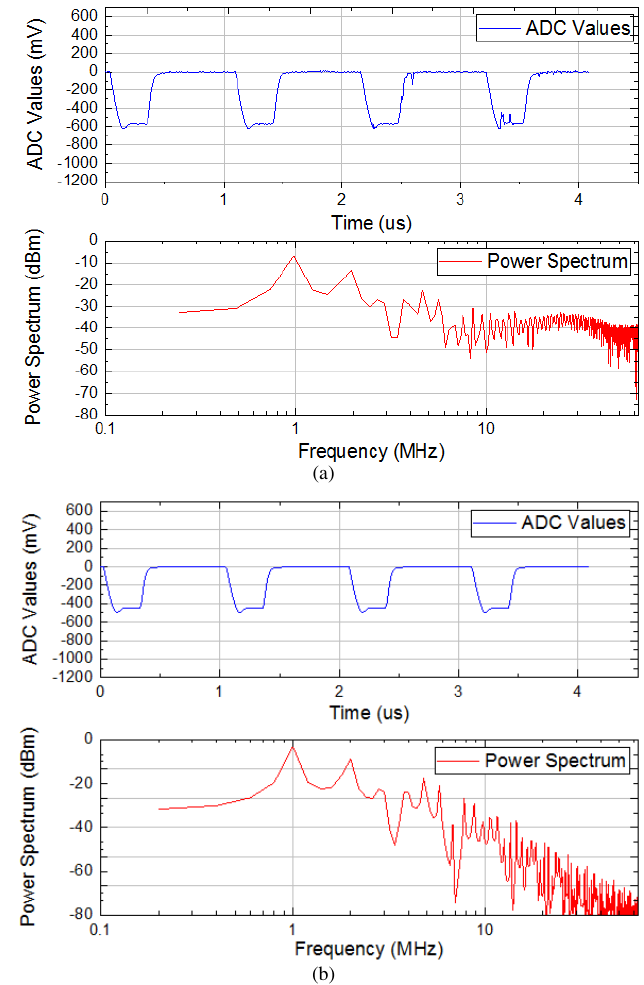
Fig. 3. Acquired data (a) and reference signal (b) shown in time and frequency domain acquired by HDO4000A. The total measurement is 512